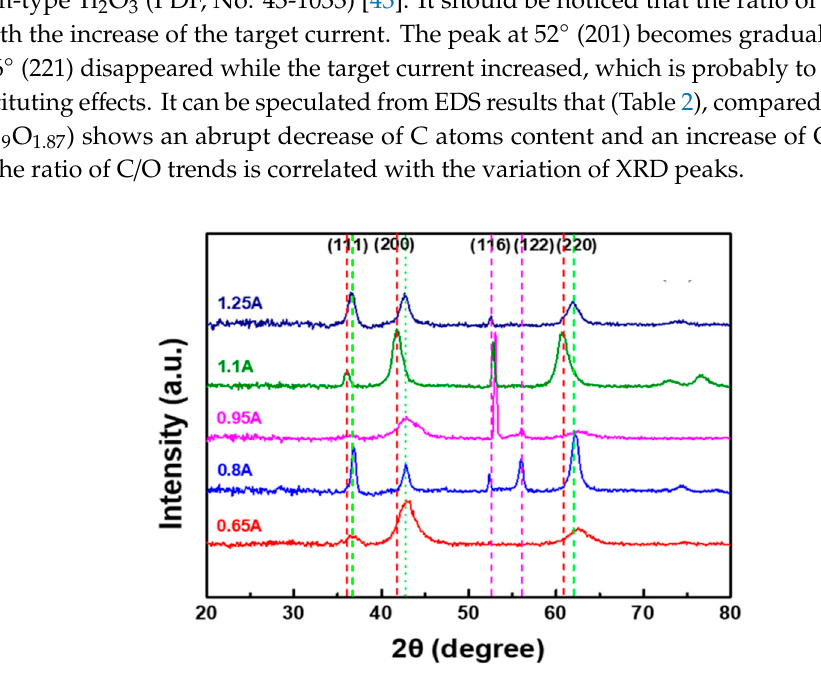
Figure 3. The X-ray diffraction (XRD) patterns: Red line, green line and purple line represent TiC, TiO 1.04 and Ti 2 O 3 peaks, respectively. Table 2. The typical data of the TiC x O y